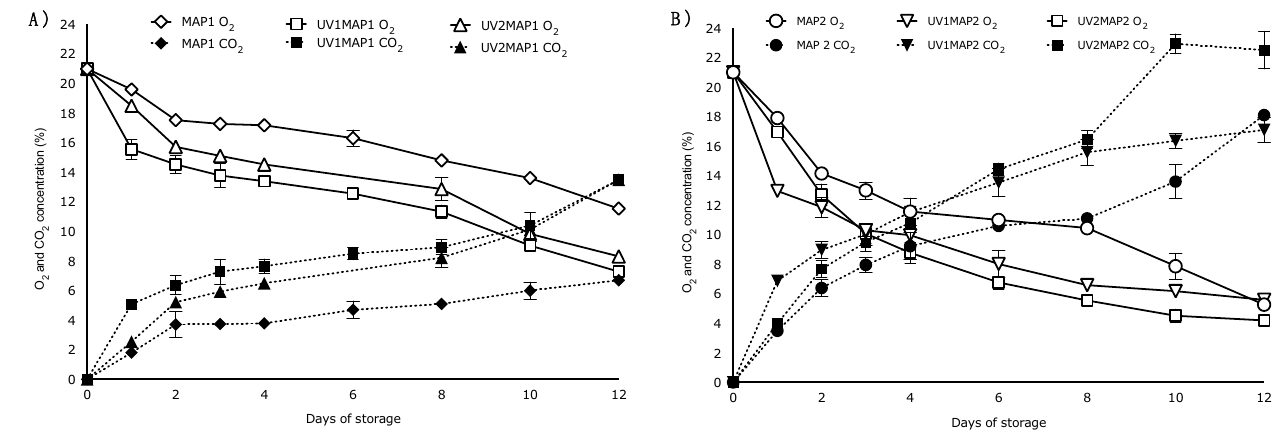
Figure 2. O 2 and CO 2 concentrations inside the packages during shelf life. Presented are the means (±S.D; n = 5) of controls and of raspberry samples, irradiated with UV-C (UV1: 2 kJ m − 2 ; UV2: 4 kJ m − 2 ) and packed using films with two transmission rates ( A ) MAP1 and ( B ) MAP2. Steady state gas compositions were not reached during storage, probably due to a gradual increase in the metabolic activity of the raspberries during storage. The increase in metabolic activity due to physiological stress has been related to the exposure to reduced concentrations of O 2 (1% to 10%) and moderate concentrations of CO 2 (10% to 15%) in strawberries [58] and raspberries [59], which may intensify the respiration activity in raspberries and, thus, the variation in the gas composition in the headspace. The onset of decay by microorganisms may also increase the respiration activity during storage, as reported in